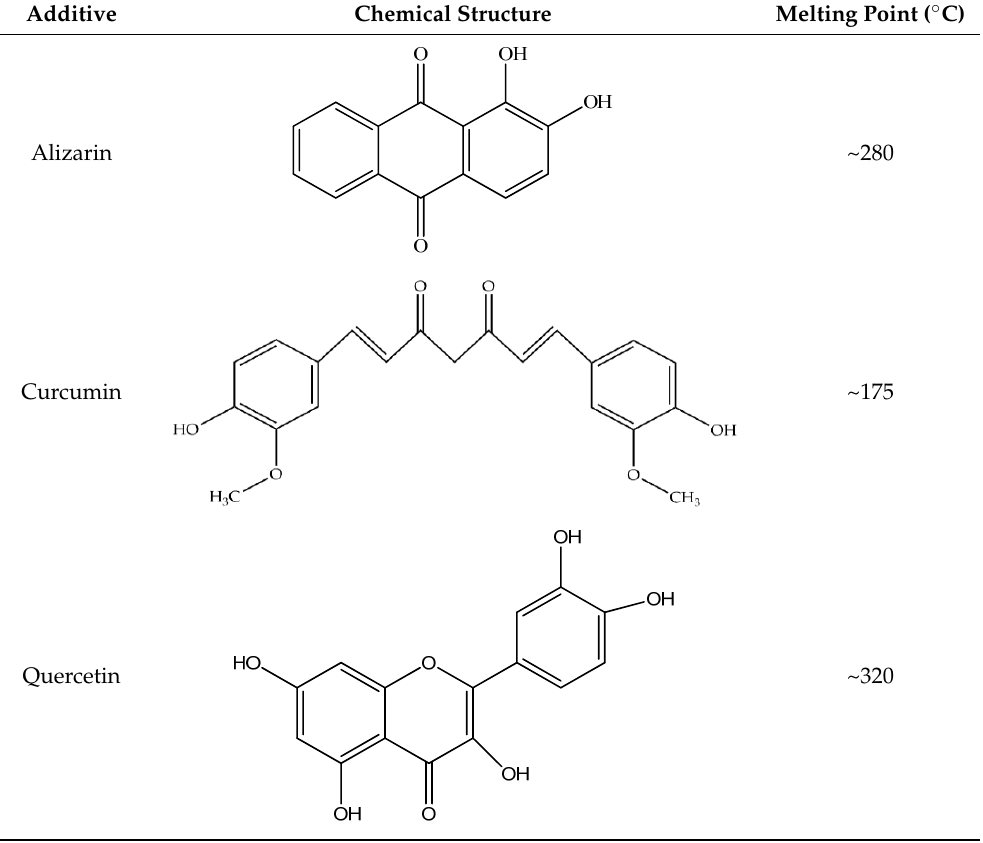
Table 1. Chemical structures and melting points of the dyes used in this study [19,27]. Additive